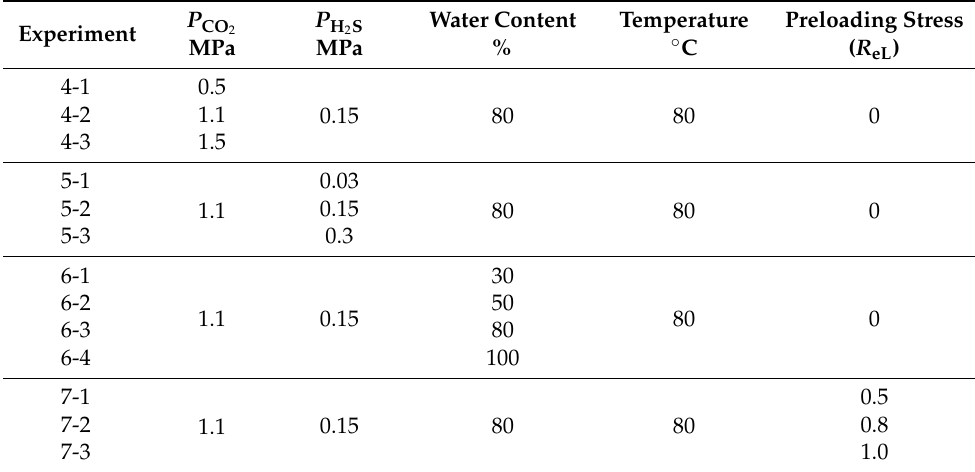
Table 4. Test conditions of immersion